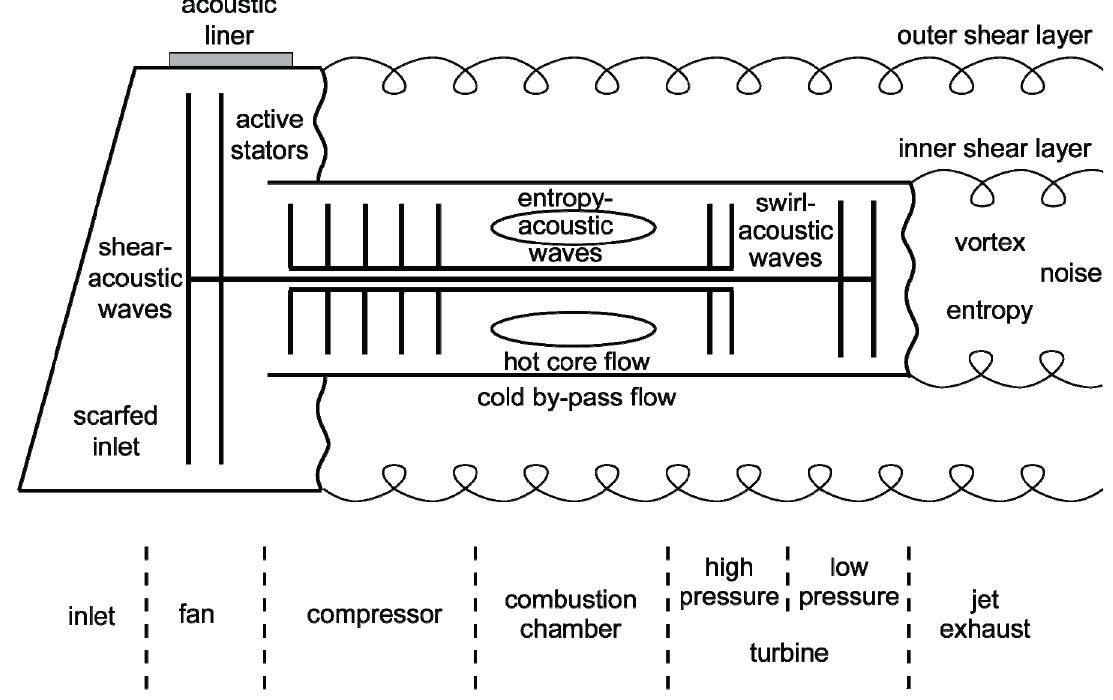
Figure 16. Noise sources and reduction in a turbofan engine. The diagram of a turbofan engine emphasizes the relation between its mode of operation and the noise sources: (i) the scarfed inlet with extended lower lip provides some shielding of fan noise in the forward direction; (ii) the chevron nozzle with undulations along the lip enhances the outer shear layer and reduces fan noise radiated rearwards; (iii) the acoustic liners in the fan duct and elsewhere (e.g., exhaust duct) absorb sound; (iv) the acoustic-shear waves in the fan